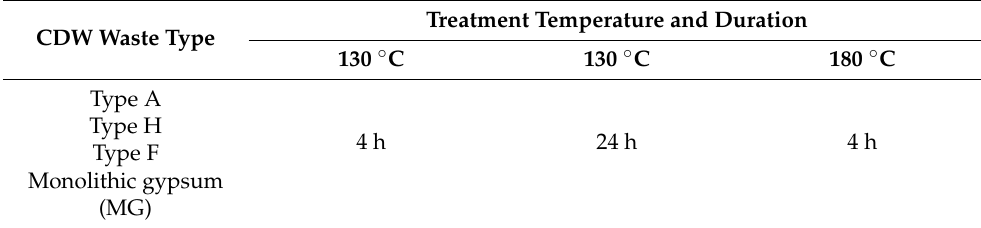
Table 1. Treatment parameters of CDW gypsum to obtain secondary binder.